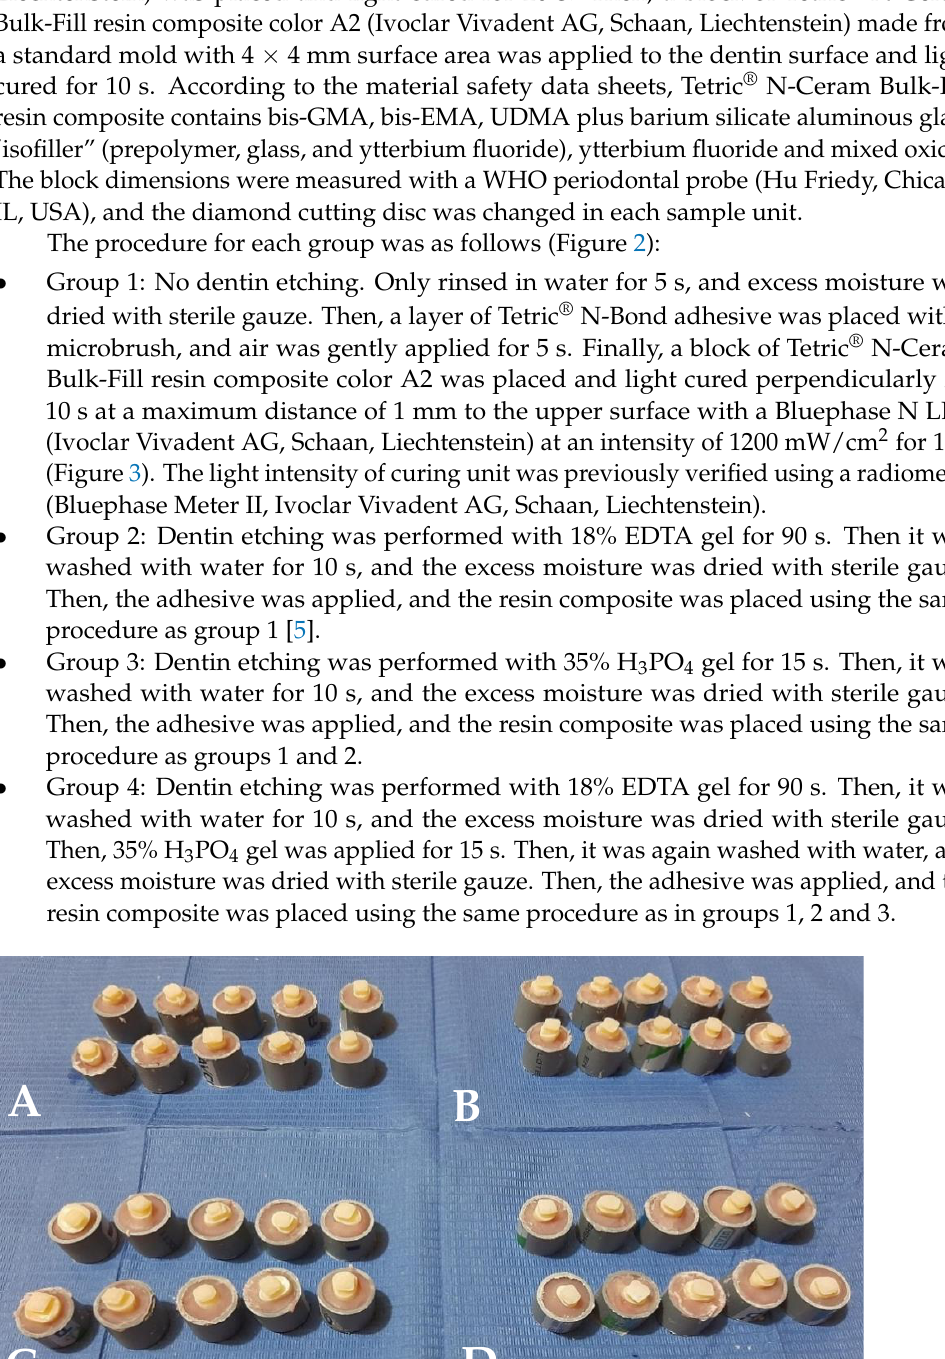
Figure 3. Light curing of Bulk-Fill resin blocks with LED unit. 2.5. Shear Strength Test The roots of the 40 sample units were immersed in self-curing acrylic (Vitacryl, Vi- talloy, Lima, Peru) in cylindrical molds to facilitate their handling in the shear test. The 40 prepared samples were subjected to a shear strength study using a universal testing ma- chine (CMT-5L, 7419 series, Liangong Group, Jinan, Shandong, China) with digital soft- ware (Smart Test) at a crosshead speed of 0.75 mm/min. A 1 mm wide bevel cutting bar located on the upper head of the universal testing machine was used. This head, when descending at the indicated speed, came into contact with the sample resin – dentin junc- tion located on the lower head. As the bar descended, it exerted a force (Newton) that was counteracted by the resistance (MPa) provided by the resin – dentin bond. This force reached its maximum value when the separation between resin composite and dentin oc- curred. To obtain the bond strength values in megapascals (MPa), the shear stress formula was used: R = F/A, where R is strength, F is the force in newtons obtained with the uni- versal testing machine and A is the bond area expressed in mm2 and constitutes the worked area (Figure 4).